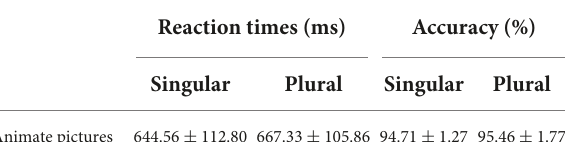
TABLE 4 Behavioral performance summary in Experiment 2 (mean ± SD) ( N =